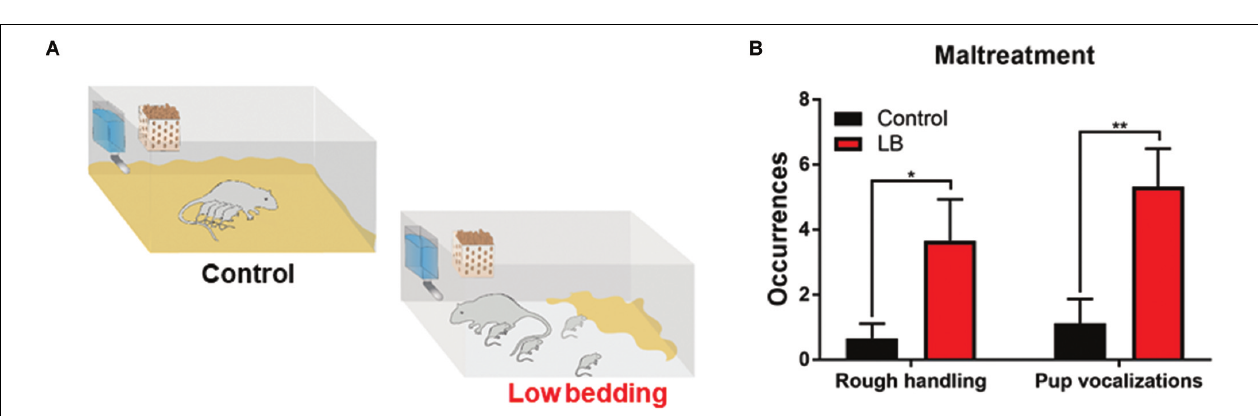
FIGURE 2 | Low bedding induces maternal maltreatment of pups. (A) Pups were exposed to either Scarcity-Adversity Model of low bedding (LB) rearing or control rearing from postnatal days (PN)8-12. LB rearing involved providing the mother with insufficient bedding for nest building, which produces maltreatment of pups